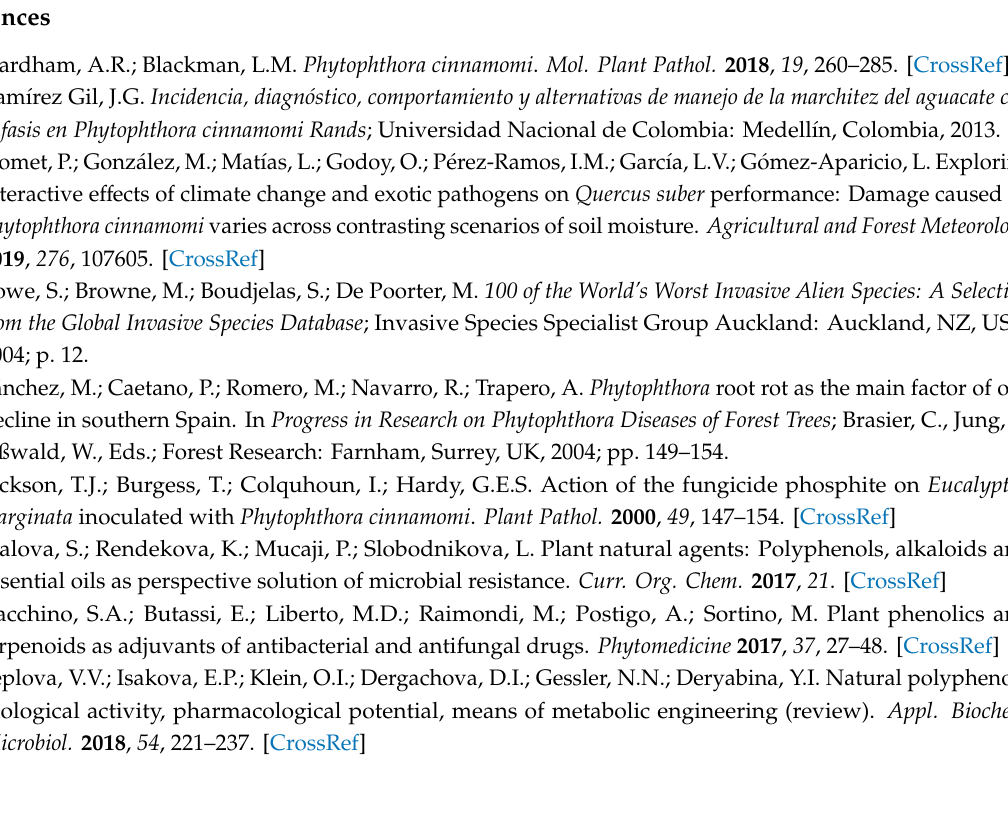
Figure S1: Example of sensitivity test. Radial growth of mycelium for the control and treatments with curcumin, ferulic acid, gallic acid and silymarin; Table S1: Test of between-subjects e ff ects; Table S2: Categories as a function of radial growth values for each polyphenol*dose*AgNPs combination, with a confidence interval of 95%, by Tukey’s HSD